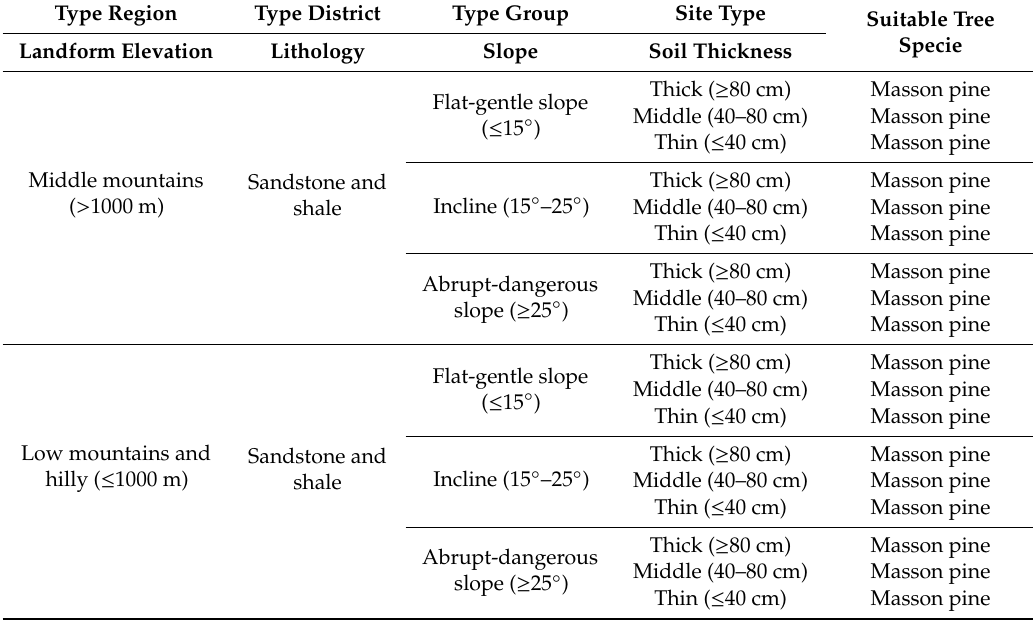
Table 5. Summary of empirical site rules from Guizhou Plantation Survey and Design.